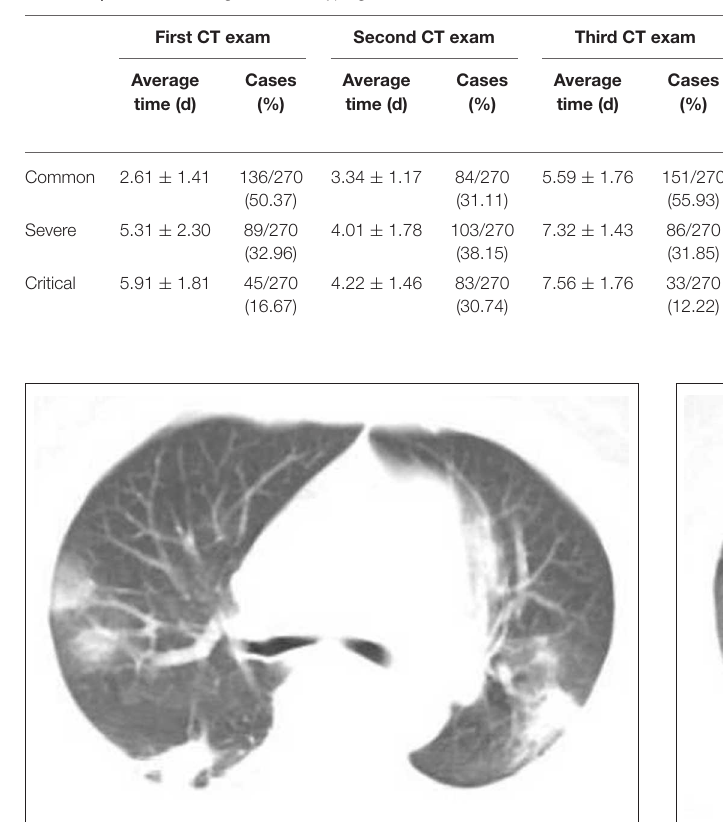
FIGURE 3 | Female, 56 years, with fever pending investigation. HRCT plain scan axial lung window showing lesions in bilateral lung lobes at the first time. The same patient was re-examined after 4 days, and the lesion range increased, showing the severe type